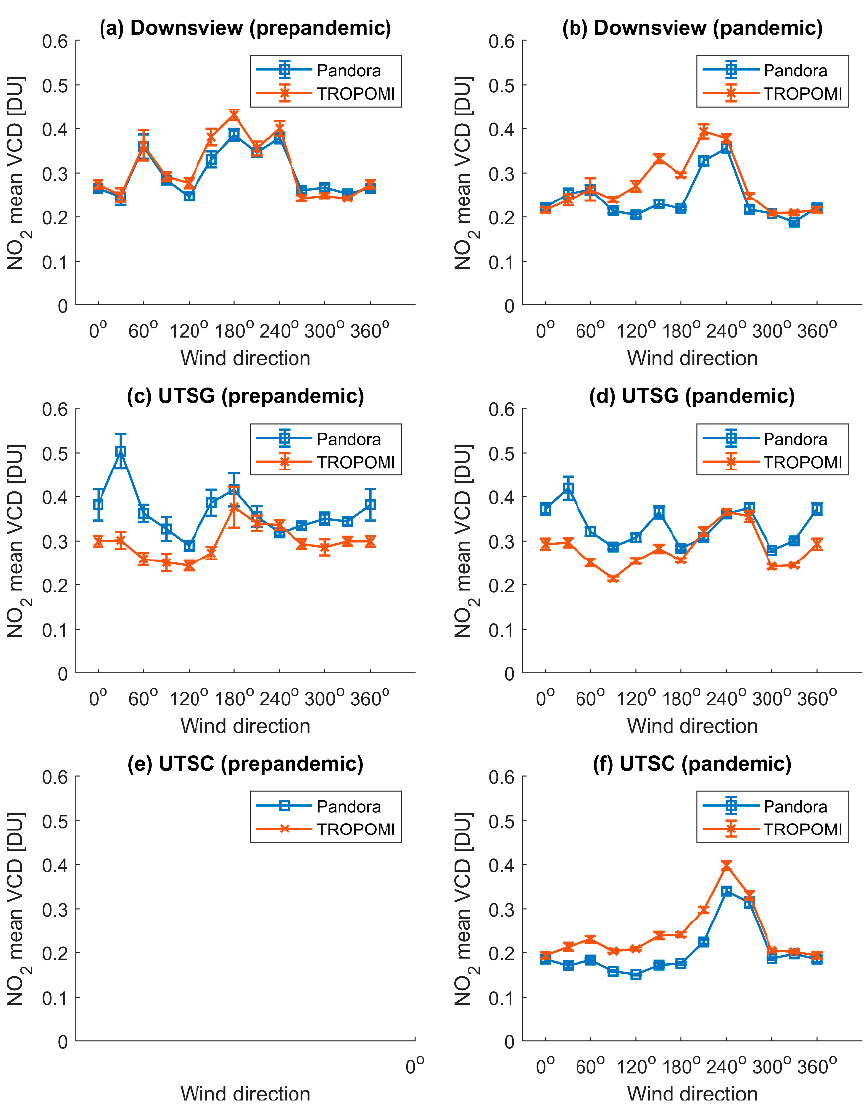
Figure 11. TROPOMI and Pandora NO 2 total column (VCD) measurements at Downsview, UTSG, and UTSC binned by wind direction, using data from before the pandemic ( a , c , e ) and since pandemic ( b , d , f ). Error bars are the standard error of the mean. Unlike Figures 4 and 6, only Pandora mea- surements taken within ± 1 h around the TROPOMI overpass time were used (observations from 15 March to 15 September for each